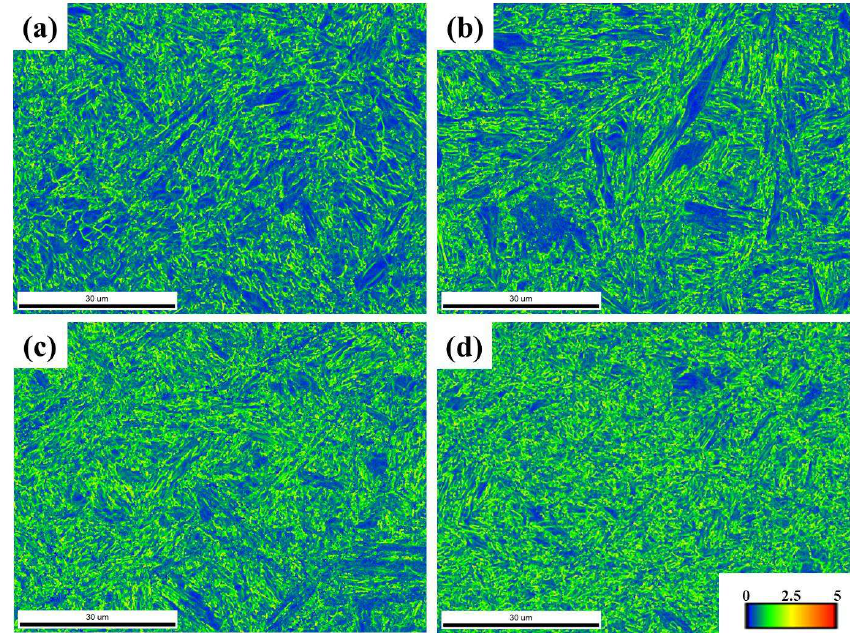
Figure 8. KAM maps of 18CrNiMo7-6 alloy steel ( a ) 950 °C/0.01 s −1 ; ( b ) 1150 °C/0.01 s −1 ; ( c ) 1050 °C/0.01 s −1 ; ( d ) 1050 °C/1 s −1 .